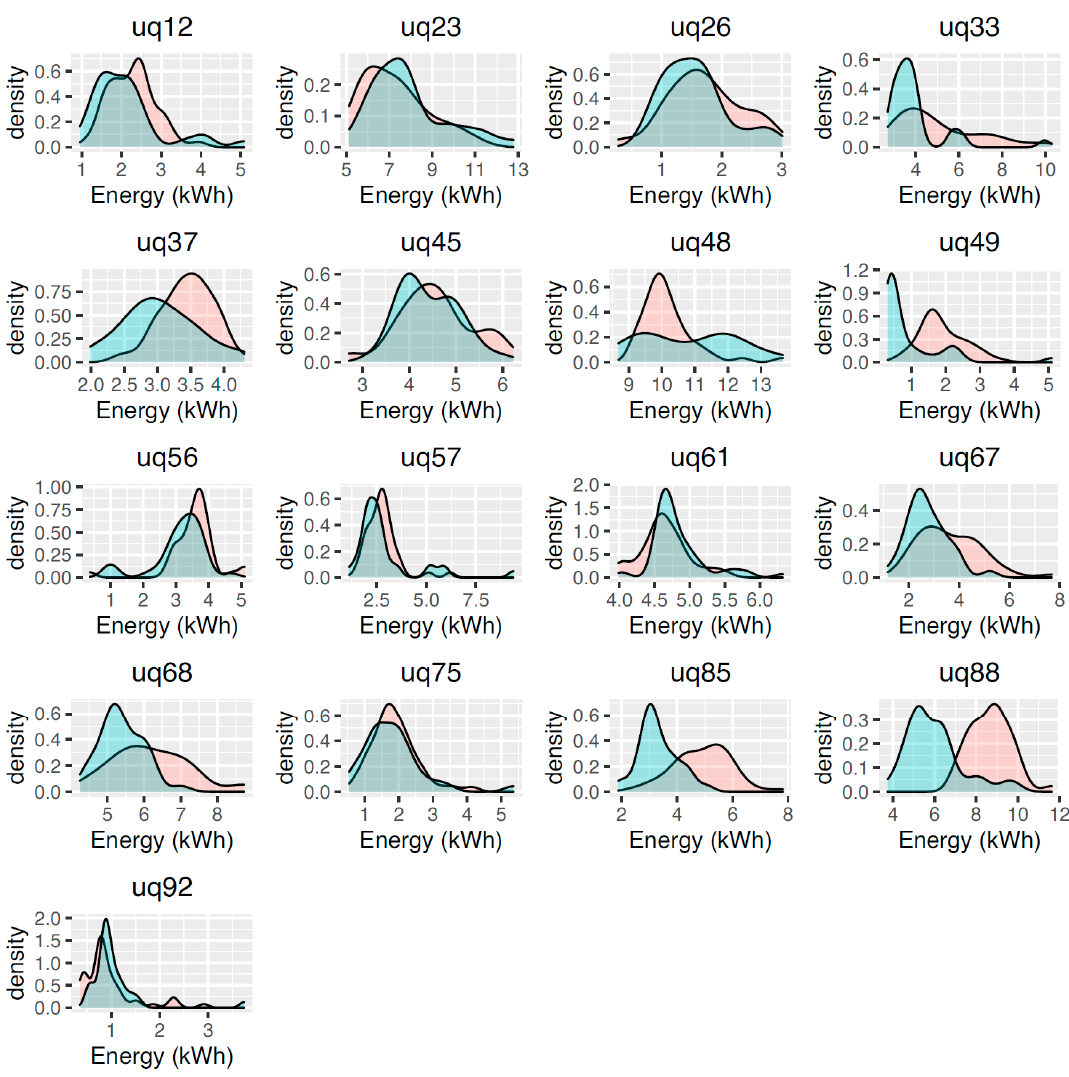
Figure 3. Power points circuits 9 am–5 pm weekday changes in energy use (after controlling for seasonality) pre-lockdown (blue) vs. during lockdown (red). seasonality) pre-lockdown (blue) vs. during lockdown